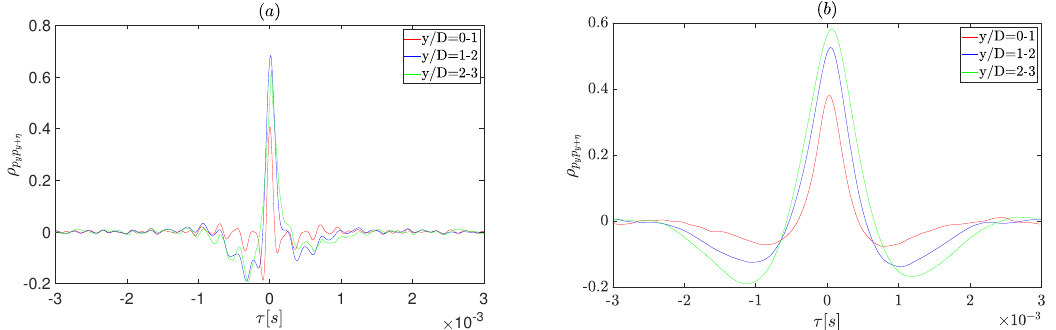
Figure 7. Span-wise evolution of the wall pressure cross-correlation coefficient for the jet-plate distance H/D = 0.75 and jet Mach number M j = 0.5: ( a ) x/D = 5; ( b ) x/D = 25.